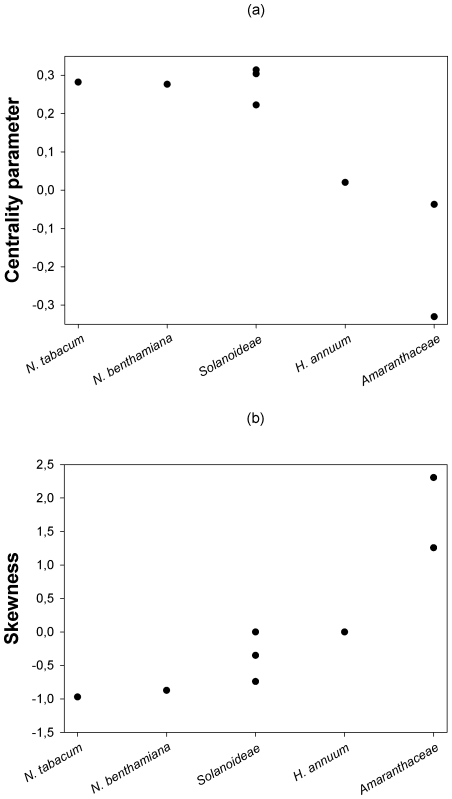
Changes in the centrality and shape parameters of the DMFE with increasing genetic distance among hosts.(a) The centrality parameter of the best fitting pdf shifts from positive to negative Malthusian fitness, indicating that the average effect of single mutations is stronger as the host genetic relatedness with the natural host N. tabacum decreases. (b) Distributions become more positively skewed with increasing host genetic distance from N. tabacum, suggesting that more mutations have positive effect in the new hosts.